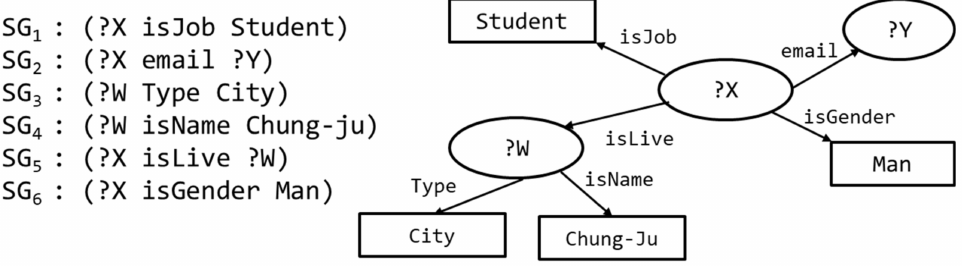
Figure 3. Example of a SPARQL query.